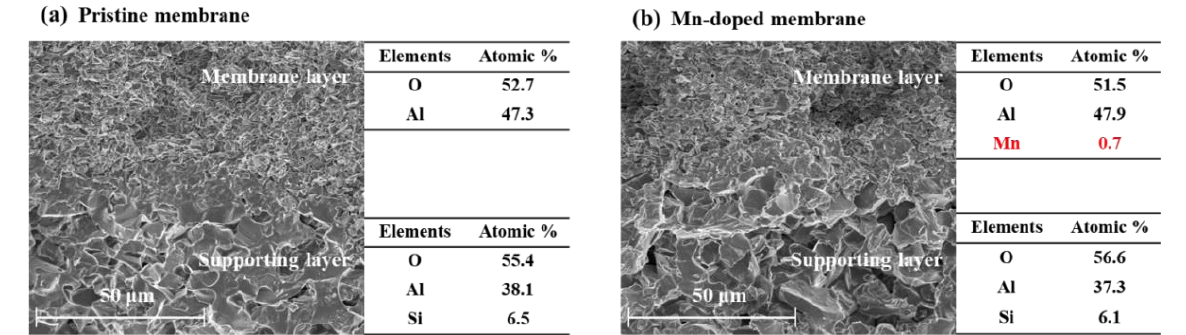
Figure 2. The cross-section morphologies and element compositions of the pristine membrane ( a ) and Mn-doped mem- brane ( b ).